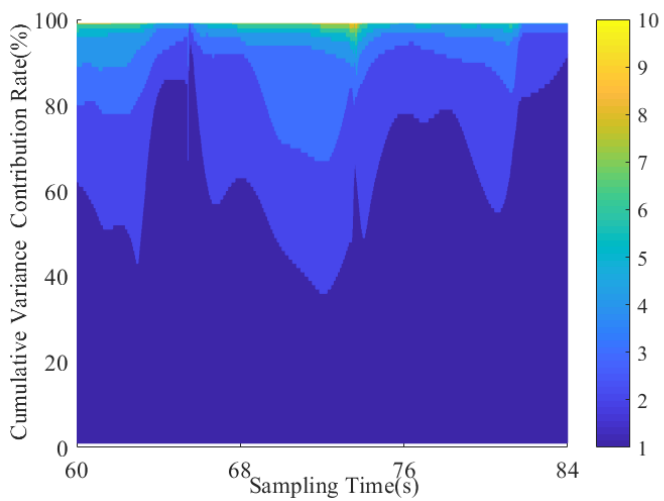
Figure 7. A top view of Figure 6. The number of principal components is shown by the color bar on the right side of the